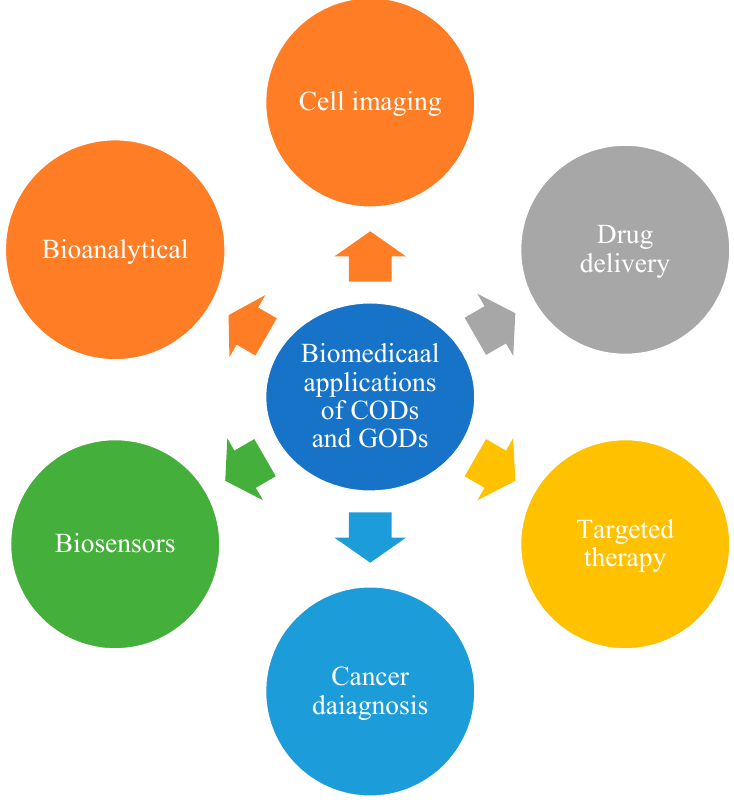
Figure 3. Biomedical applications of CODs and GODs.